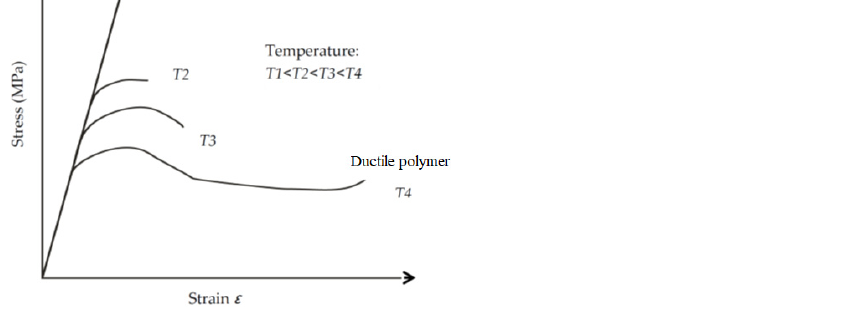
Figure 4 . Effect of temperature on the mechanical properties of the polymer. Adapted from [71]. Figure 4. Effect of temperature on the mechanical properties of the polymer. Adapted from Viscoelasticity, two types of deformations exist, namely elastic and viscous. Elastic deformation is recoverable, while viscous deformation is a plastic deformation where the deformation is permanent upon removing the applied stress [71].